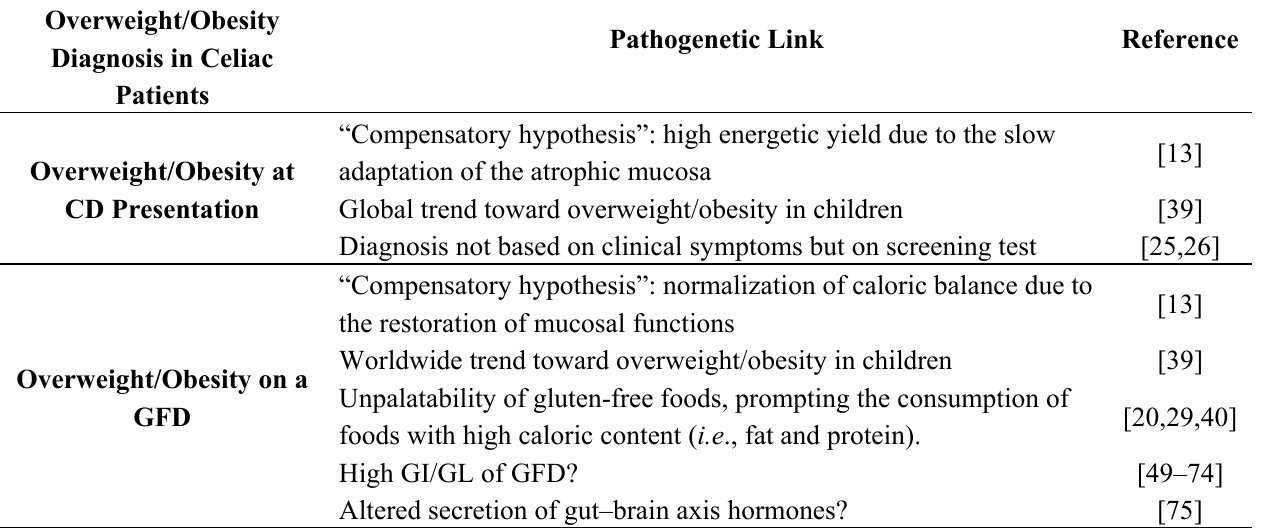
Table 2. Suggested pathogenetic links between CD and